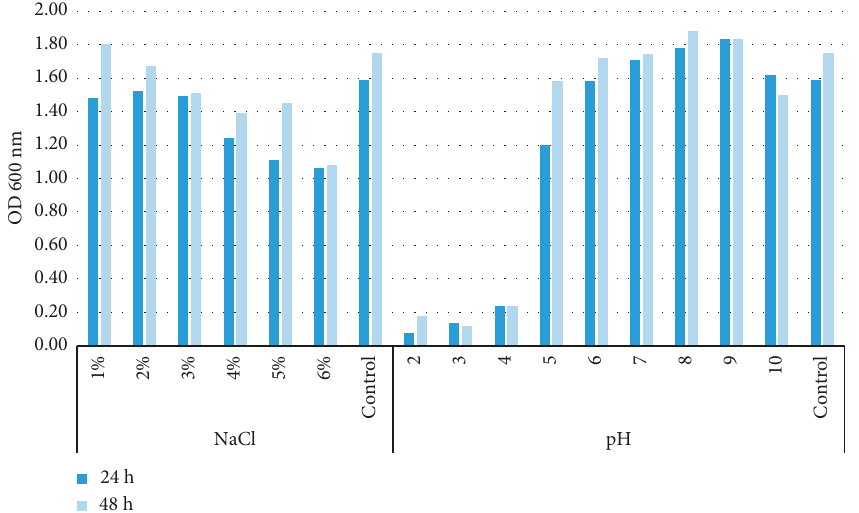
Figure 3: Tolerance to different pH values and